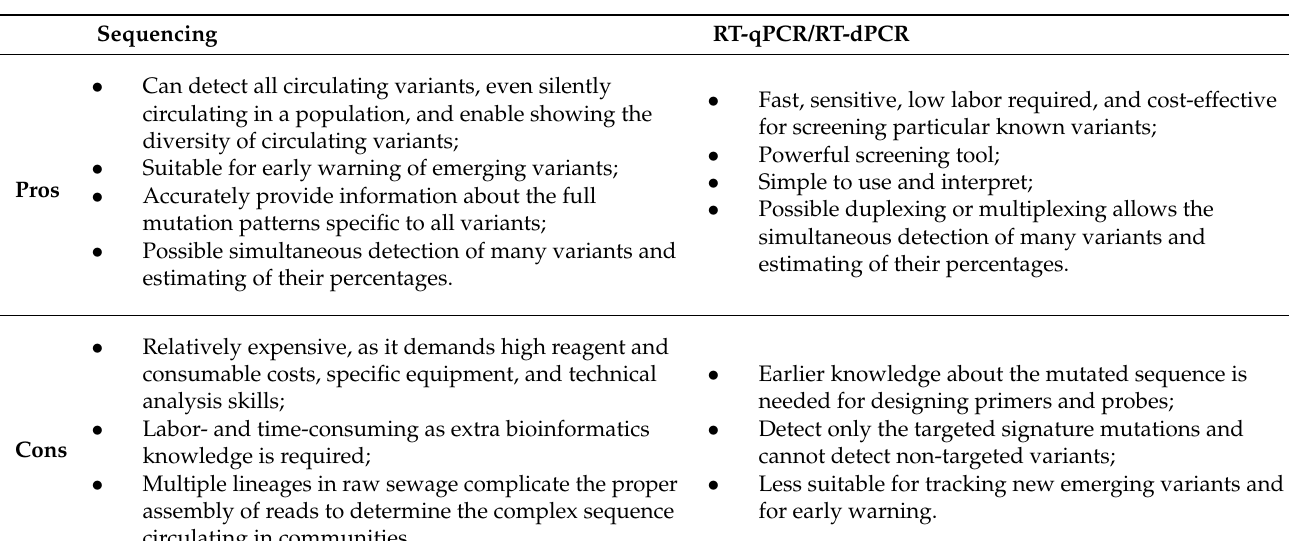
Table 2. Comparing pros and cons of sequencing and RT-qPCR/RT-dPCR based methods for detect- ing SARS-CoV-2